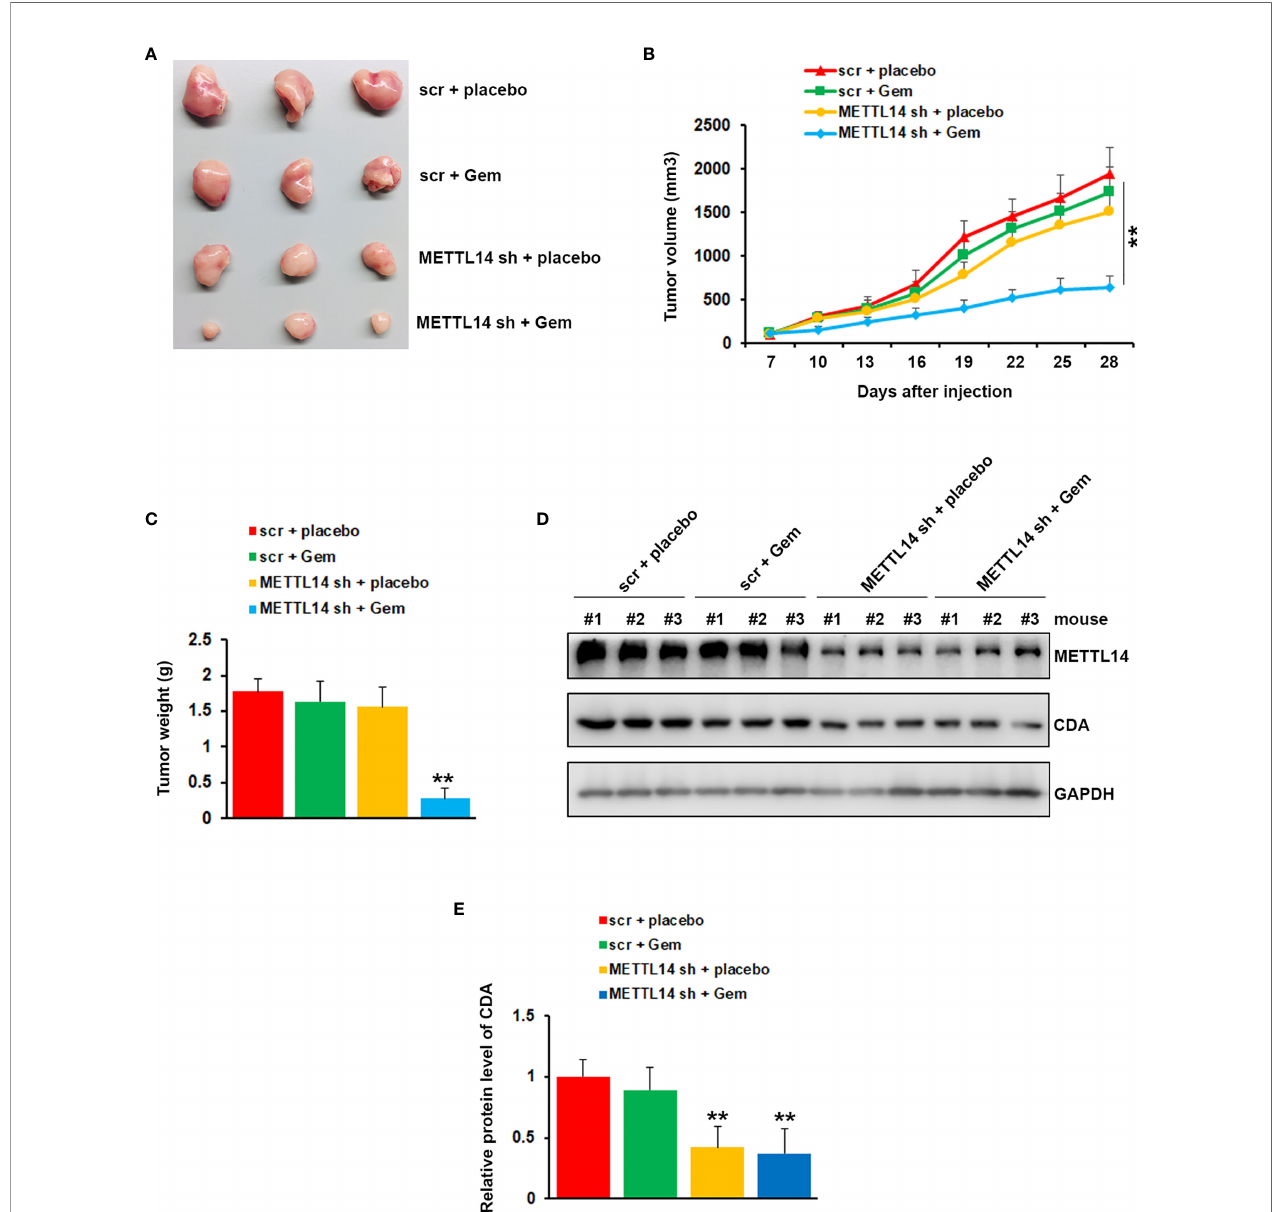
FIGURE 6 | Effects of METTL14 depletion on gemcitabine resistance in vivo . (A) Typical photos of tumors from each group. (B, C) Tumor growth curve (B) and weight (C) indicated that METTL14 depletion signi fi cantly rescued the response of PANC-1 GemR cells to gemcitabine. **p < 0.01. (D) Protein level of CDA and METTL14 in 3 representative tumors from each group were analyzed by western blotting. (E) Quanti fi cation of CDA protein levels in 3 representative tumors from each group. **p <